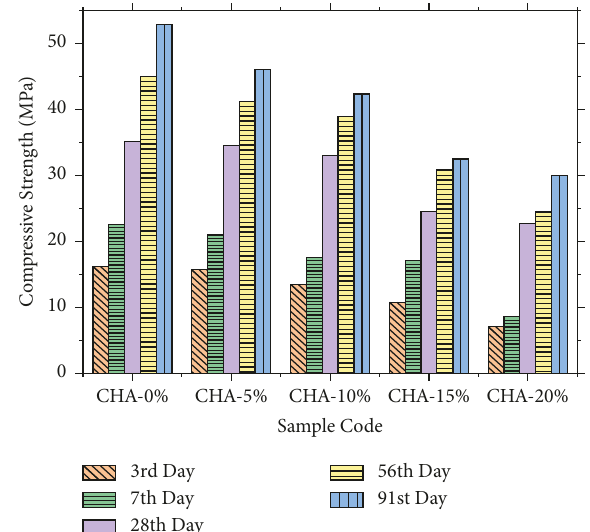
Figure 7: Compressive strength of concrete in different curing days.